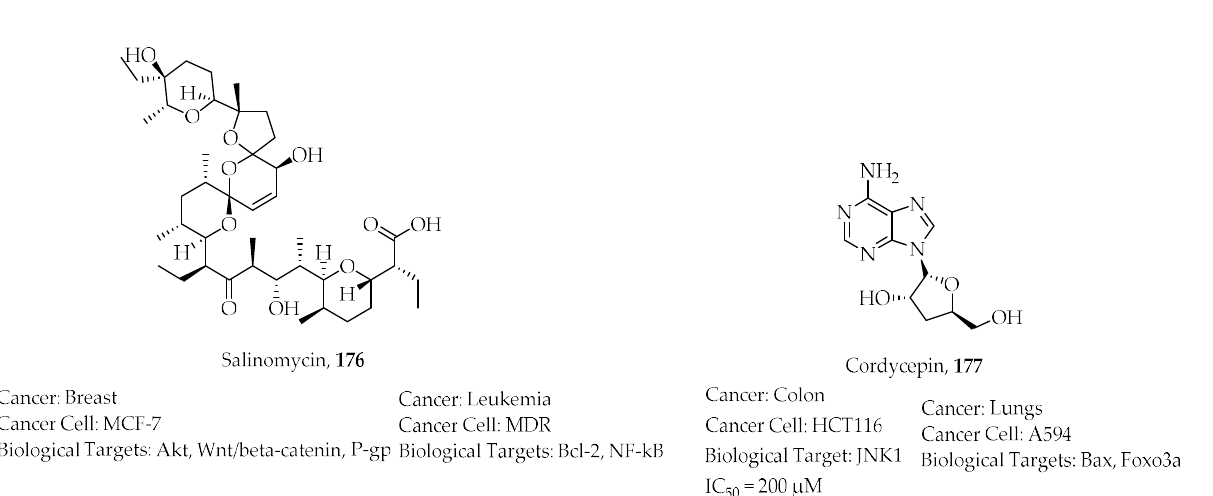
Figure 44. Structures of the sestertepenoid Ophiobolin and the spiro alkaloid Penicitrinine A with a summary of their biological activity towards selected cancer targets.